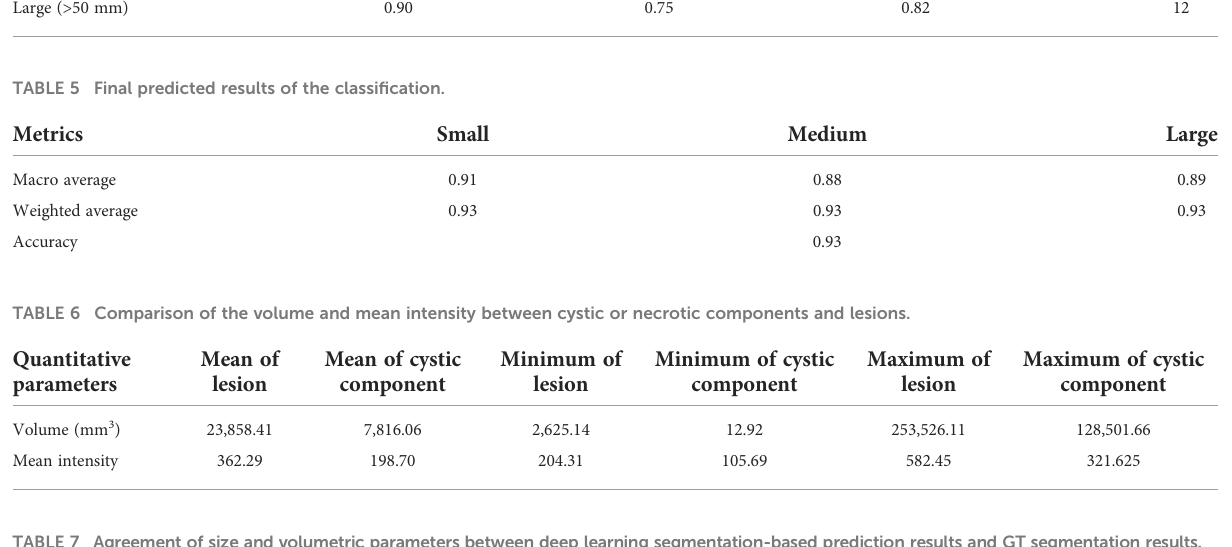
TABLE 7 Agreement of size and volumetric parameters between deep learning segmentation-based prediction results and GT segmentation results.